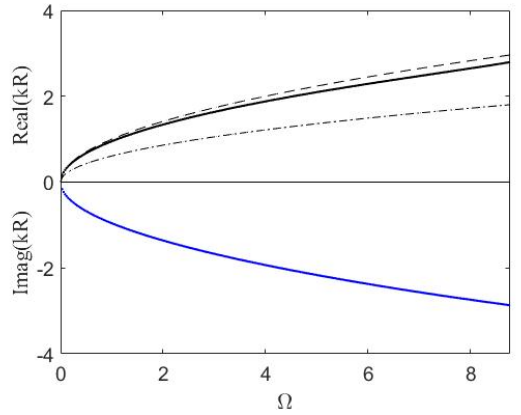
Figure 5. Dispersion curves for flexural waves in the radially periodic plate. Propagating flexural waves in the corresponding homogeneous plates of thickness h 1 , - - - - , and h 2 , - . - . - , are shown for comparison.